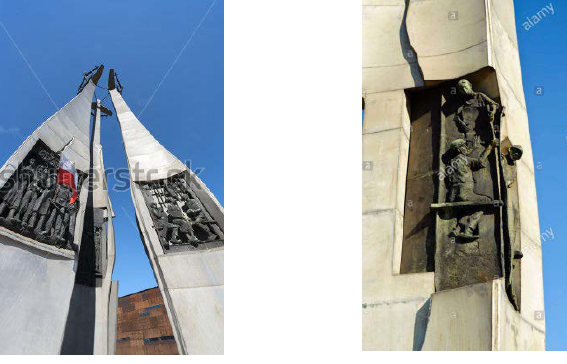
Fig. 13, memorial for the victims of the communist regime, Poland, August 2012 Solidarity Square in front of Gdansk's Shipyard. Former President of Poland